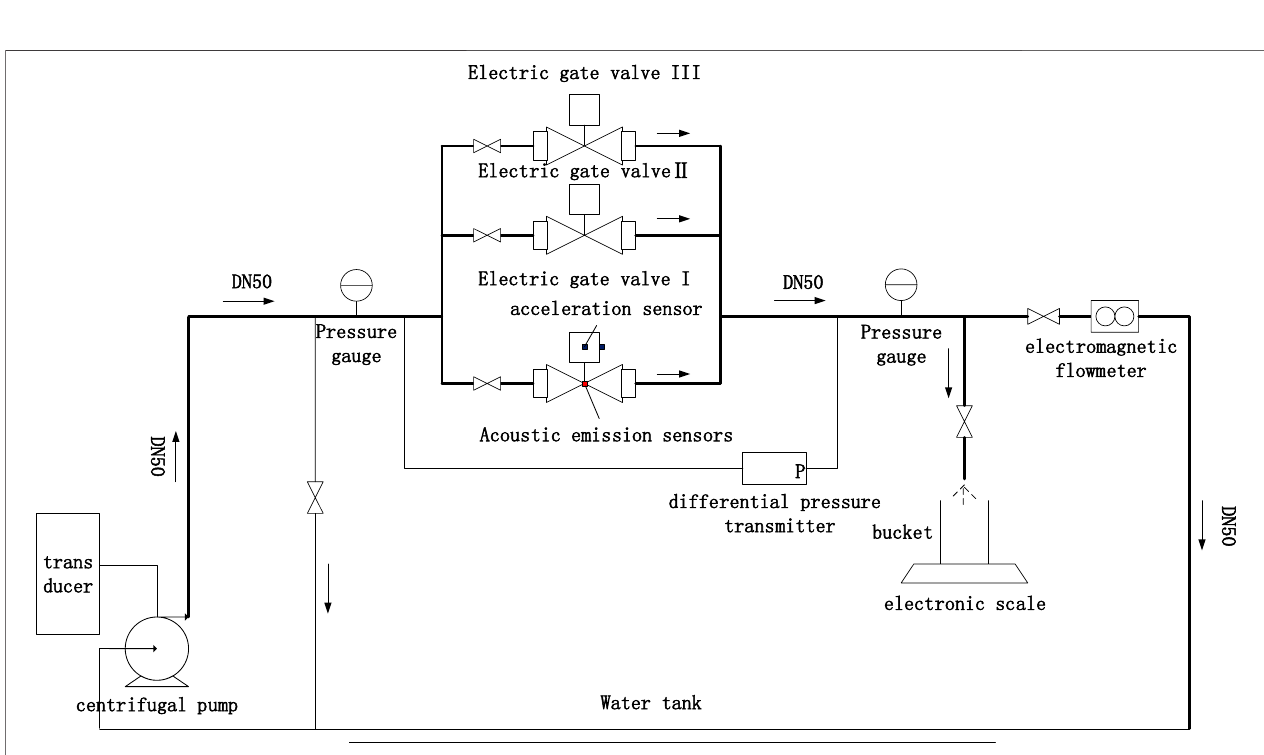
FIGURE 2 | Illustration of the electric gate valves experimental